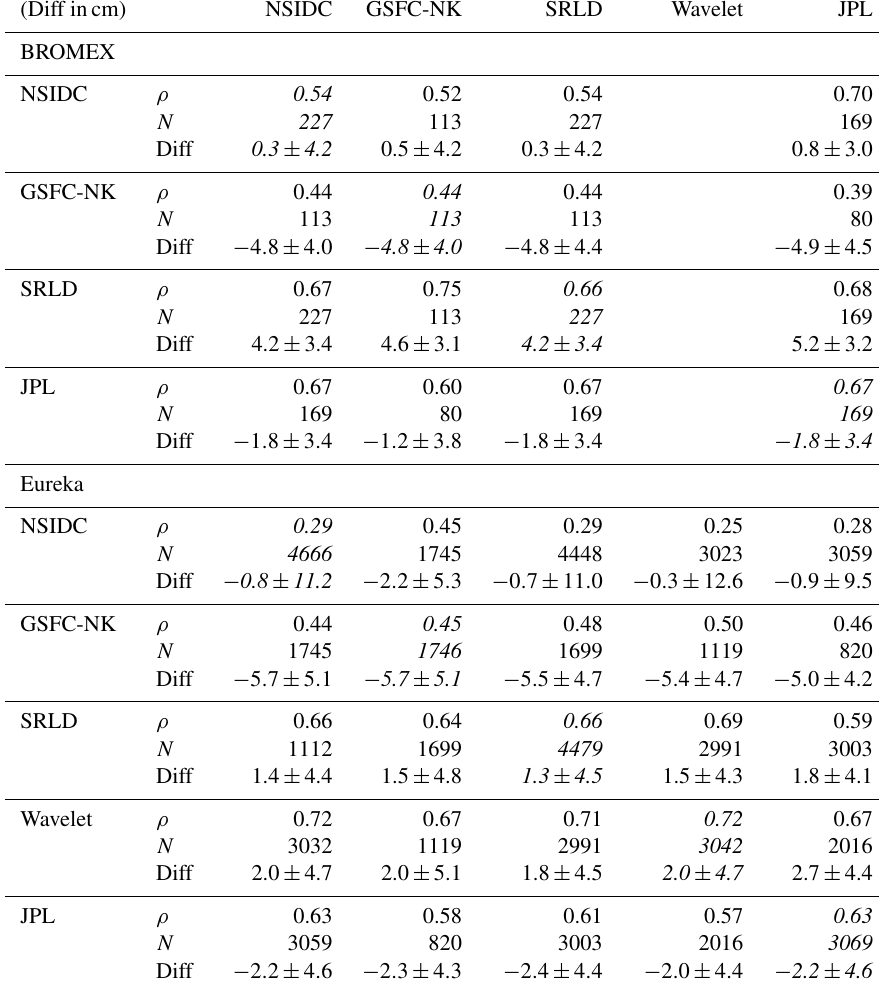
Table 4. Comparison of radar snow depth with field measurements at BROMEX and Eureka using retrievals at locations that are common to both algorithms. In the matrix presentation below, the snow depth retrieved by the row algorithm (at locations common to the column algorithm) are used in the comparisons with field data. Note that the matrix is not symmetric. Quantities in italics are from Table